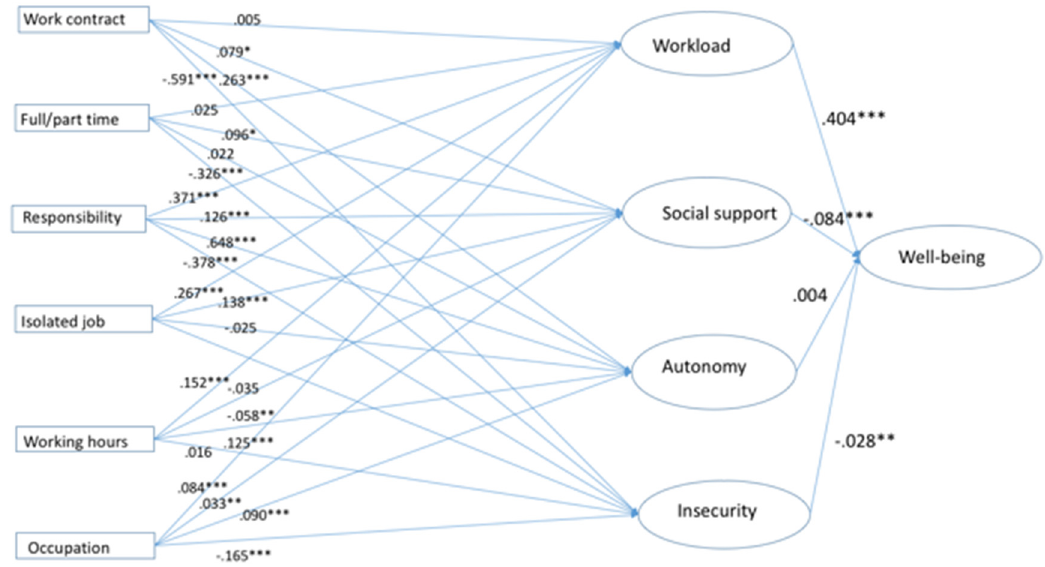
Figure 2. Structural equation model.